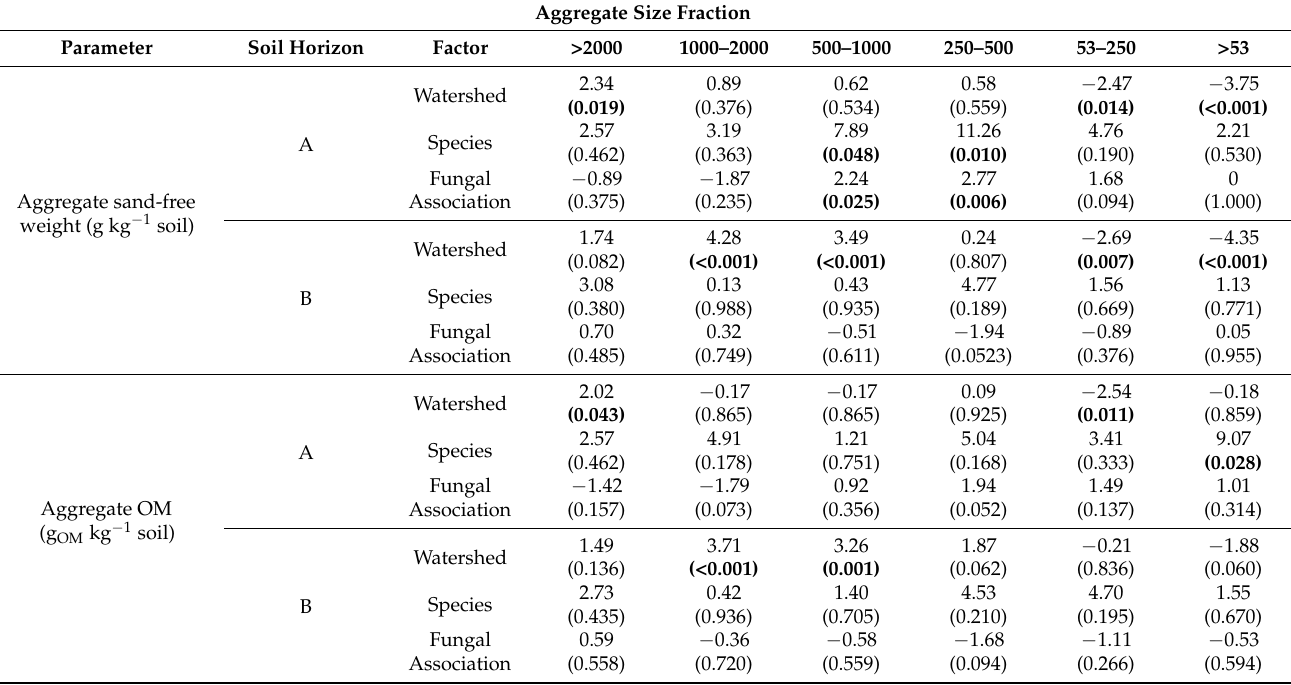
Table A1. Statistical test values for each factor by soil horizon: values represent z-scores for watershed and fungal association factors and chi-squared values for species factor. p -values are given in parenthesis. Significance is accepted at p < 0.05, and significant effects are